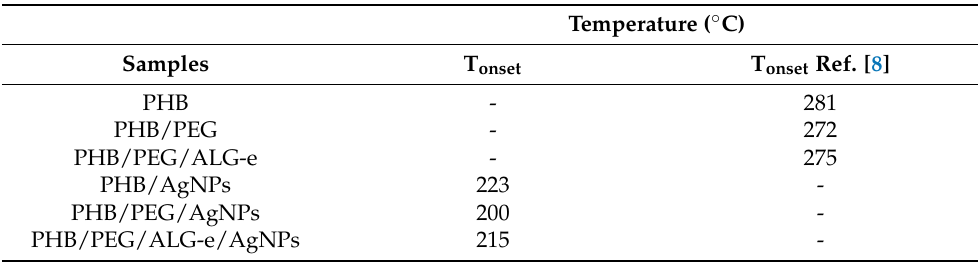
Table 4. Comparative analysis of the thermal behavior of PHB, PHB/PEG, and PHB/PEG/ALG-e blends unloaded and loaded with Ag